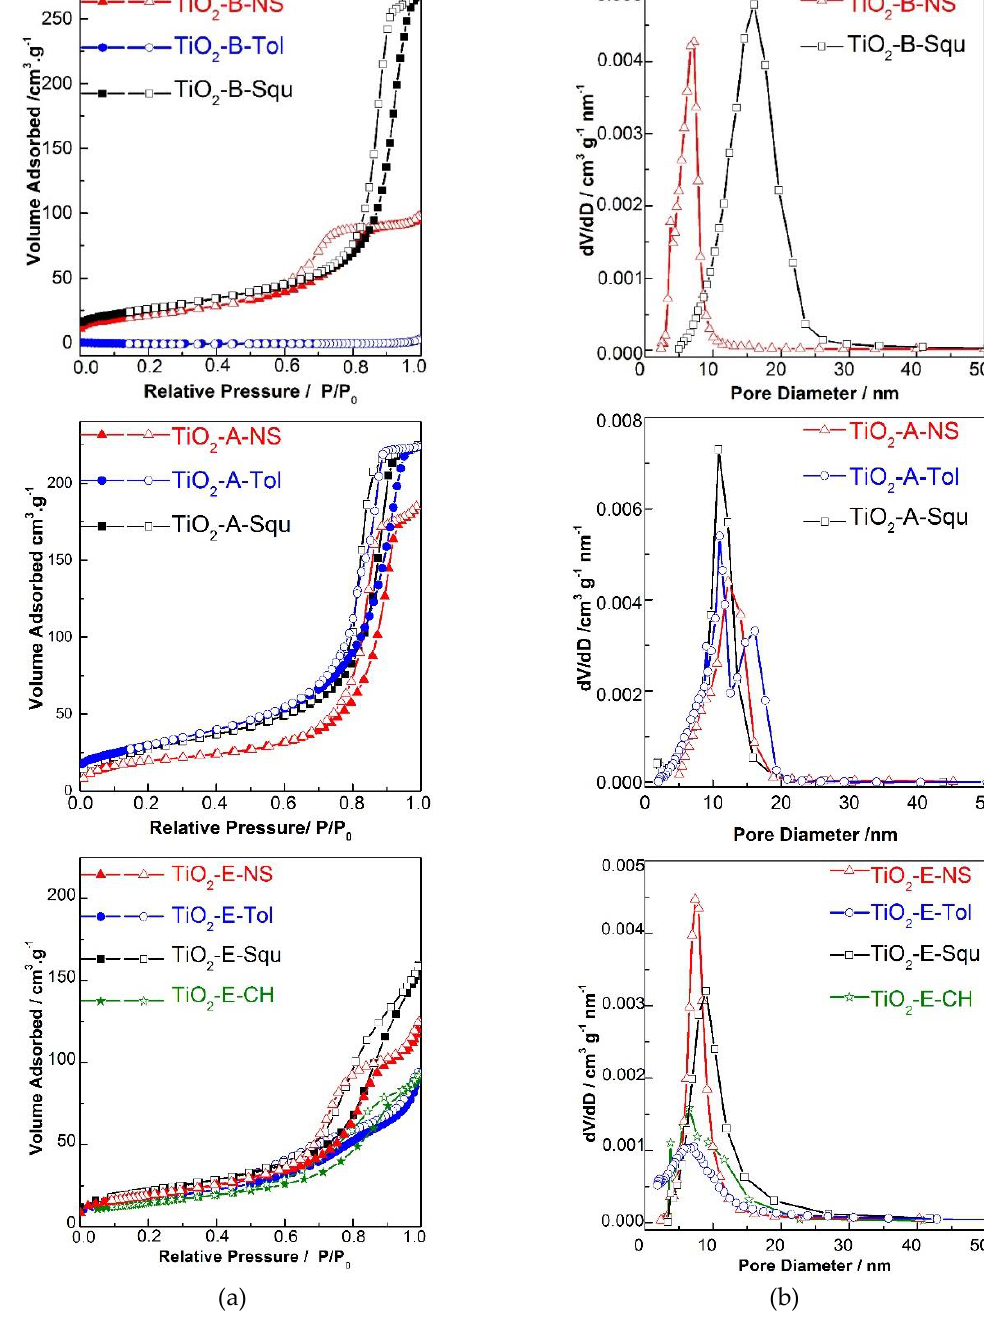
Figure 3. Nitrogen physisorption isotherms ( a ) and pore size distribution ( b ) of calcined TiO 2 samples. Filled and open symbols refer to adsorption and desorption, respectively.